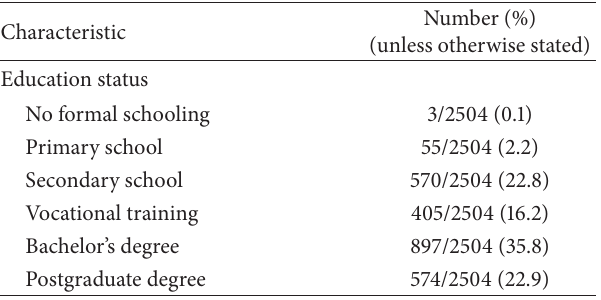
Table 3: Characteristics of the study sample.